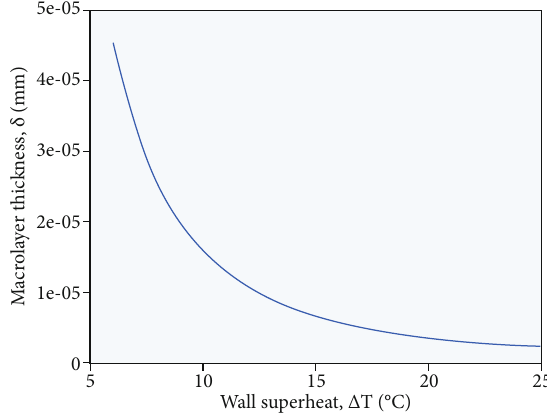
Figure 14: Heat fl ux variation with microlayer